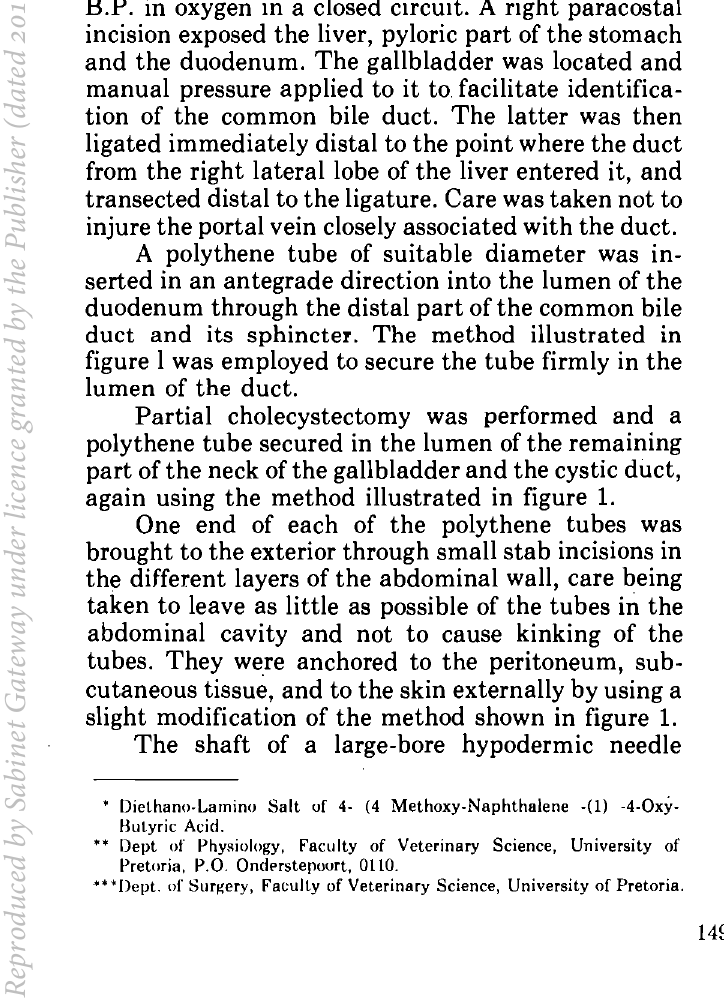
Fig. I Method used to secure artificial tubes in